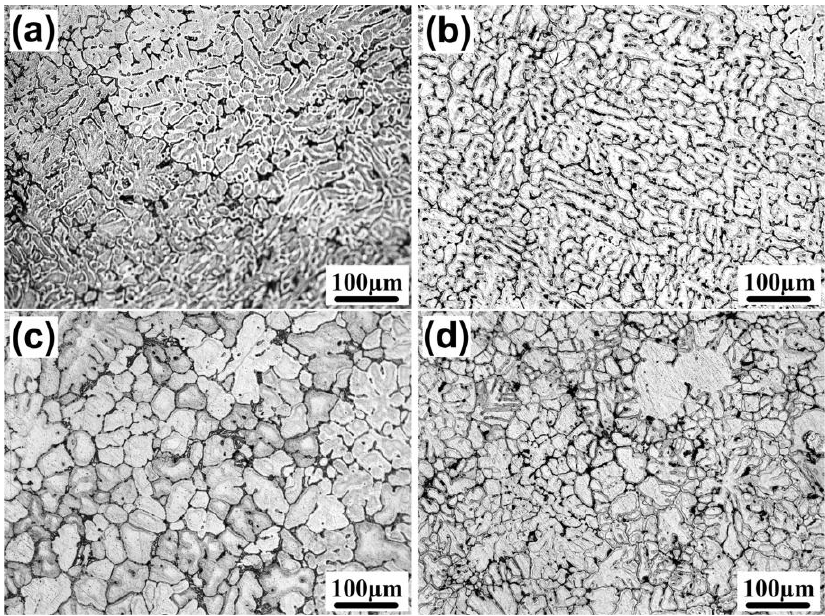
Figure 3. Cast microstructures of the nano-sized Al–Cu alloy and SiC p /Al–Cu composites with different SiC p contents; ( a ) Al–Cu alloy; ( b ) 1 wt. % SiC p ; ( c ) 3 wt. % SiC p ; ( d ) 5 wt. % SiC p .